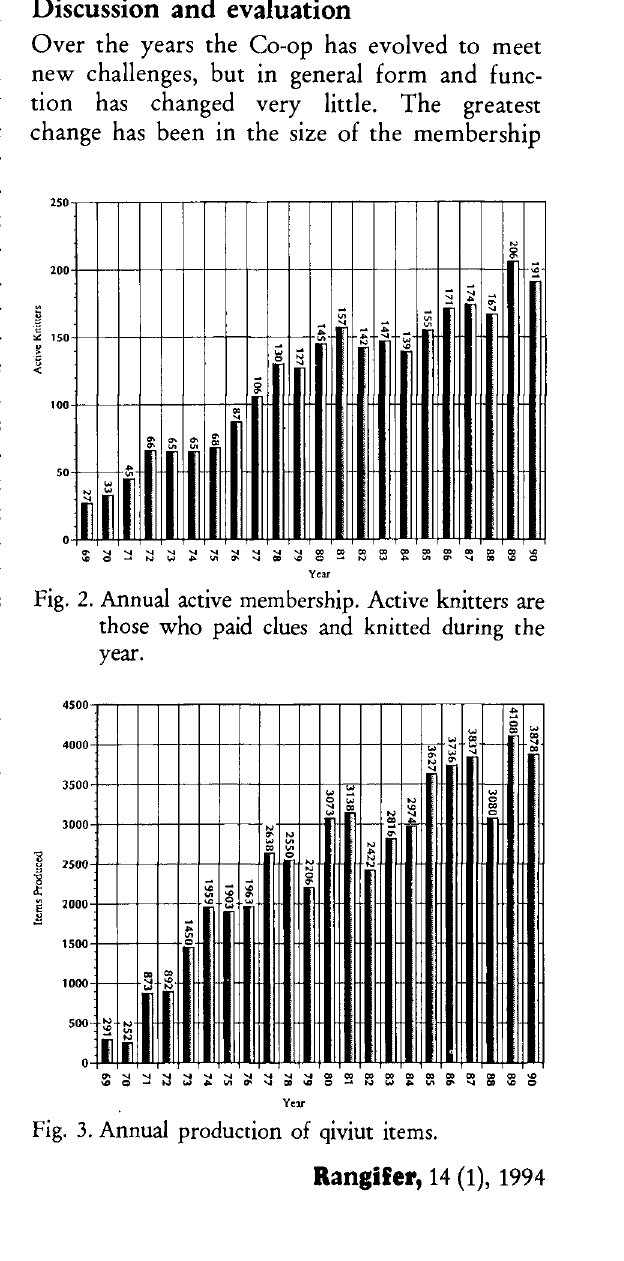
Fig. 3. Annual production of qiviut